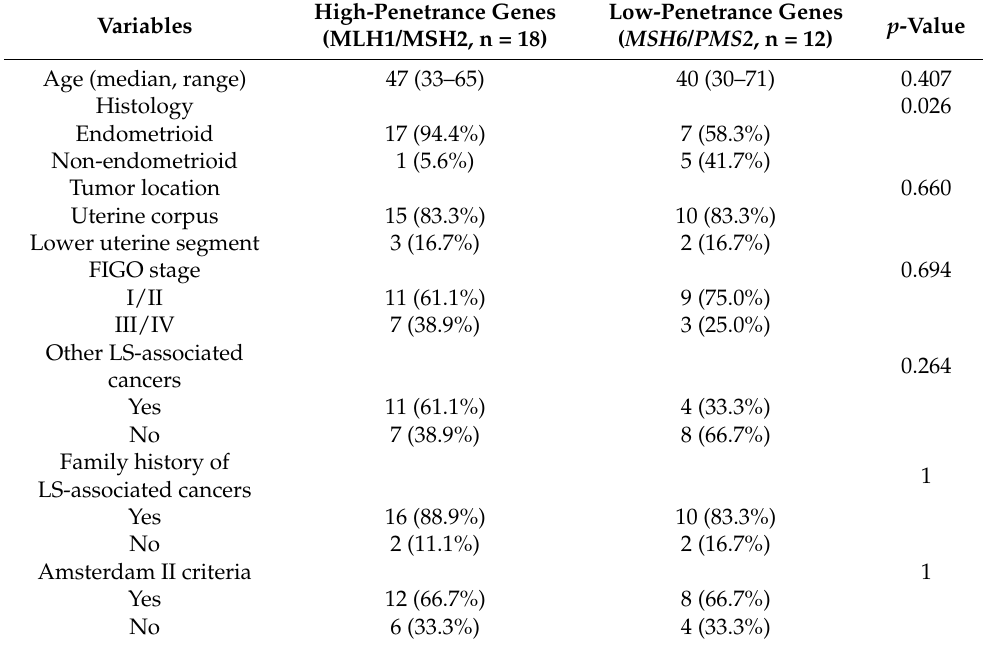
Table 4. Clinical comparison of patients with Lynch syndrome by high versus low-penetrance genes (n =